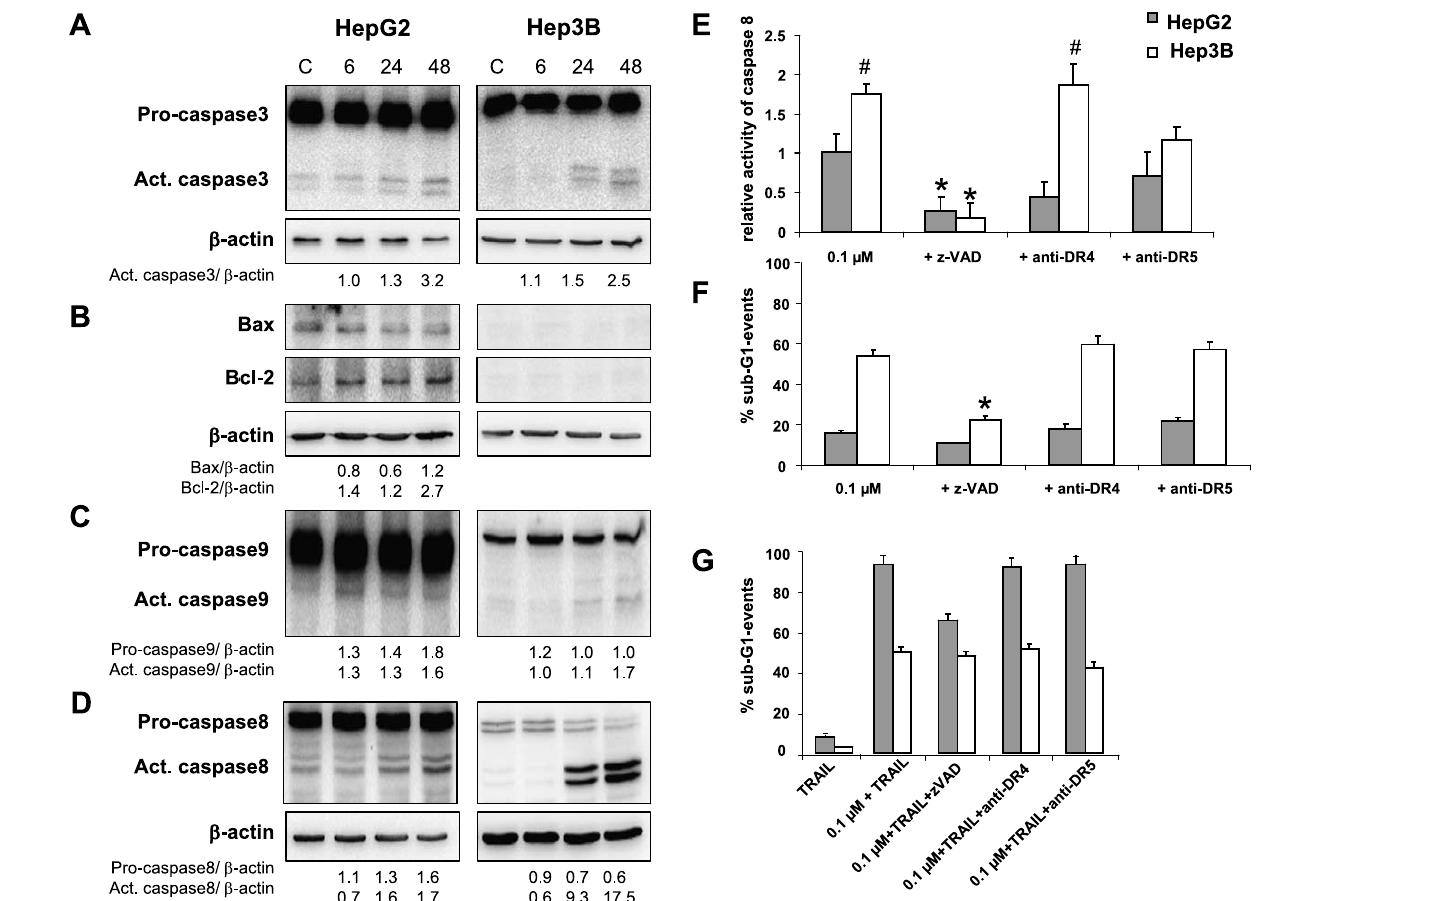
Fig. 2. Analysis of intrinsic (mitochondrial) and TRAIL-dependent (extrinsic) apoptosis pathways. Western blot analysis reveals activation of caspase 3 in both HCC cell lines after treatment with 0.1 µM panobinostat (A) but no changes in bax, bcl-2 (B) and caspase 9 (C). Analysis of expression and activation of caspase 8 after treatment with 0.1 µM panobinostat (D) shows an activation of the extrinsic apoptosis pathway in Hep3B cells. Densitometric values are normalized to β -actin and expressed relative to protein levels of untreated controls (set at 1.0). β -actin of caspase 3 also belongs to caspase 9 results. Activity of caspase 8 (E) is increased in Hep3B after incubation with panobinostat but not in HepG2. The pan-caspase inhibitor z-VAD blocks the panobinostat effect in both cell lines, while inhibitory antibodies do not influence caspase 8 activity. (F) z-VAD reduces the levels of apoptosis induced by panobinostat in Hep3B while other treatments do not interfere with HDACi. (G) Apoptosis levels after treatment with TRAIL alone or combinations of 0.1 µM panobinostat, TRAIL and specific inhibitors of caspases (zVAD) and death receptors (anti-DR4 or anti-DR5). # P < 0 . 05 vs. untreated control, * P < 0 . 05 vs. 0.1 µM panobinostat. Results are mean ± SEM of three independent